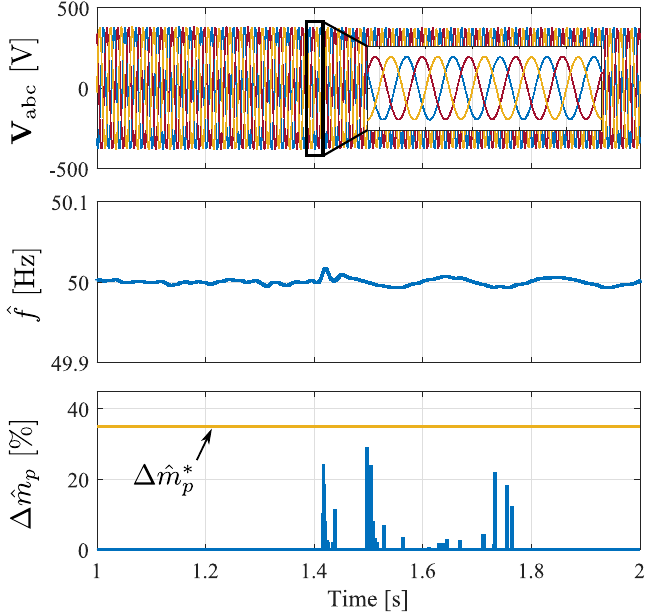
Figure 7. Case 2: Large switching load test to discard false tripping.